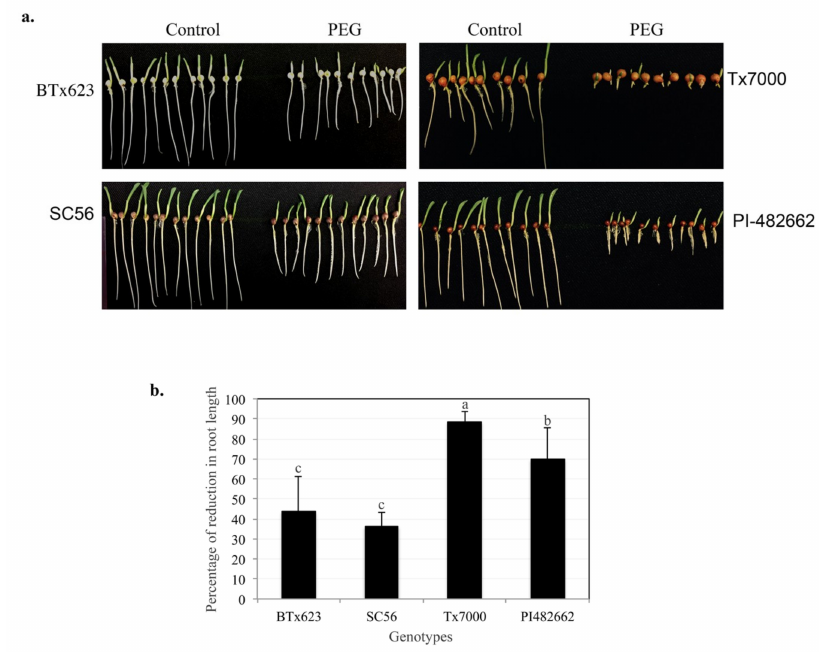
Figure 1. Evaluation of drought tolerance in four sorghum genotypes. ( a ) Seeds of four genotypes (BTx623, SC56, Tx-7000, PI-482662) were germinated and grown vertically on MS (control)